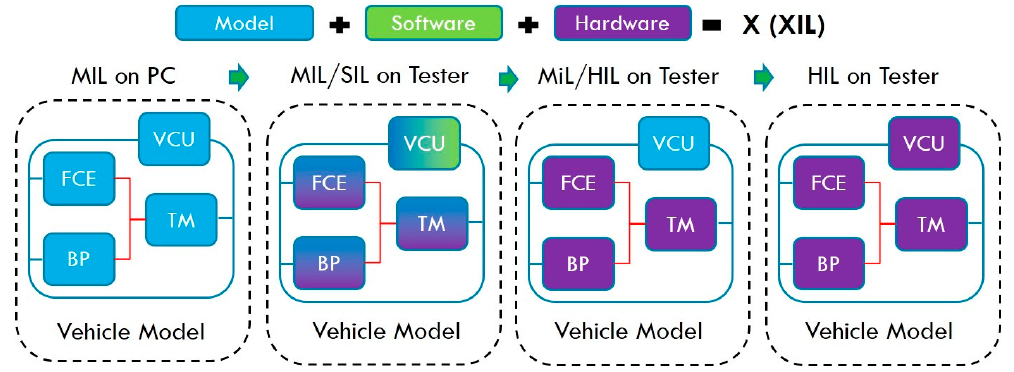
Figure 3. Hybrid degree testing process based on XiL technology.